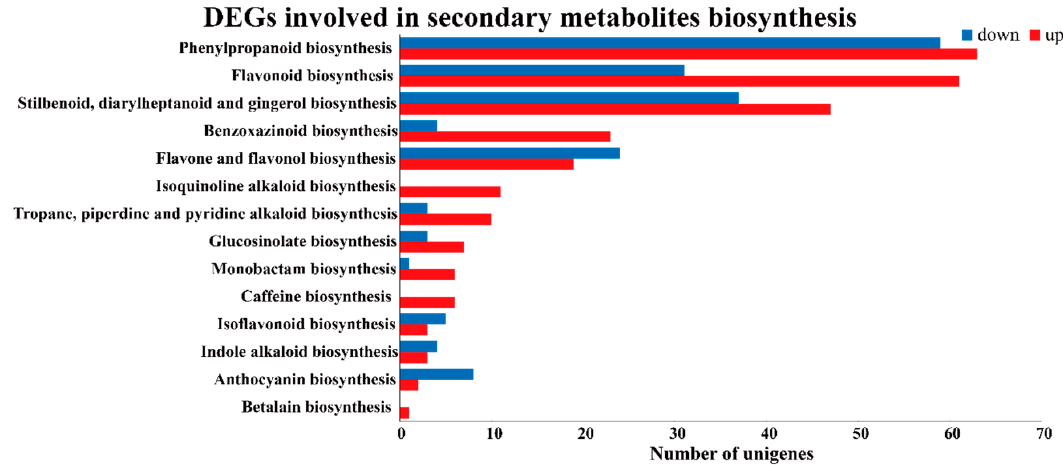
Figure 4. DEGs involved in secondary metabolites biosynthesis in buckwheat in response to salt stress.